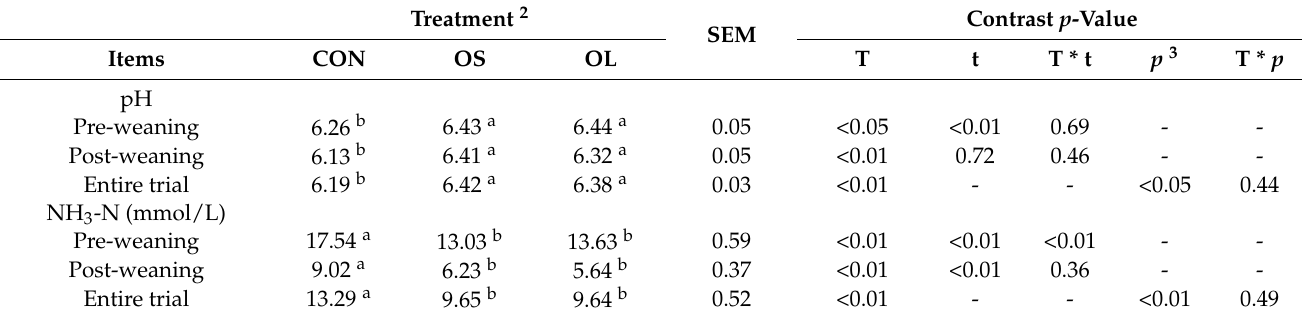
Table 3. Effects of different lengths of hay supplementation on calf’s rumen pH and NH 3 -N at dif- ferent stages 1 .